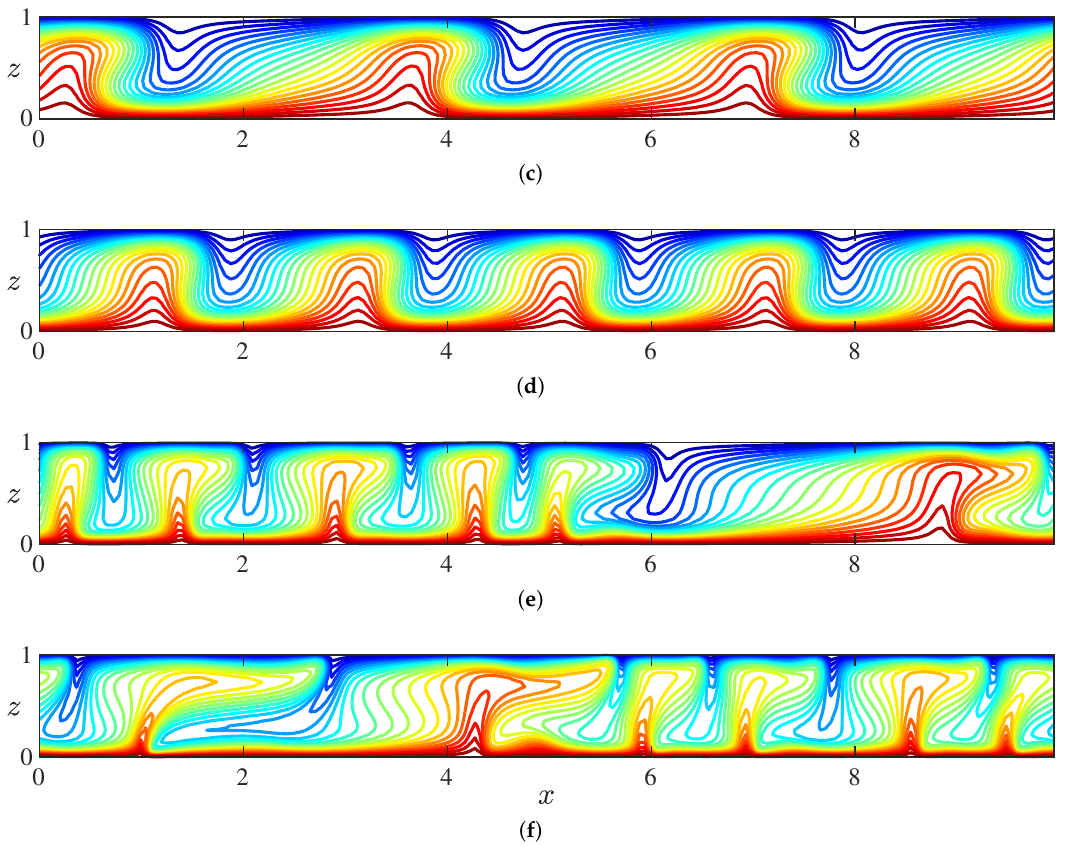
Figure 5. Snapshots of isotherms from numerical simulations at φ = 35 ◦ and L = 10. ( a – d ) Ra = 100; ( e ) Ra = 300; ( f ) Ra = 500. Sub-plots ( a – d ) show steady convective states obtained using different initial conditions, while ( e ) and ( f ) show snapshots of time-dependent states. Although the basic-state shear flow is linearly stable for φ > φ t ≈ 31.3 ◦ in 2D, convection nevertheless may be realized by initializing with sufficiently large-amplitude disturbances; i.e., sub-critical instabilities are possible in this parameter regime. The spatially-localized convective states evident in ( a , b ), observed here for the first time in single-species porous medium convection, are one manifestation of this sub-critical